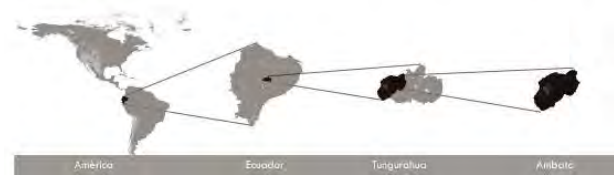
Figure 1. Location of Ambato